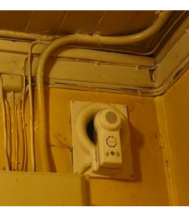
Figure 13. Integrated humidity control, occupancy sensor, and downtime (NTNU).